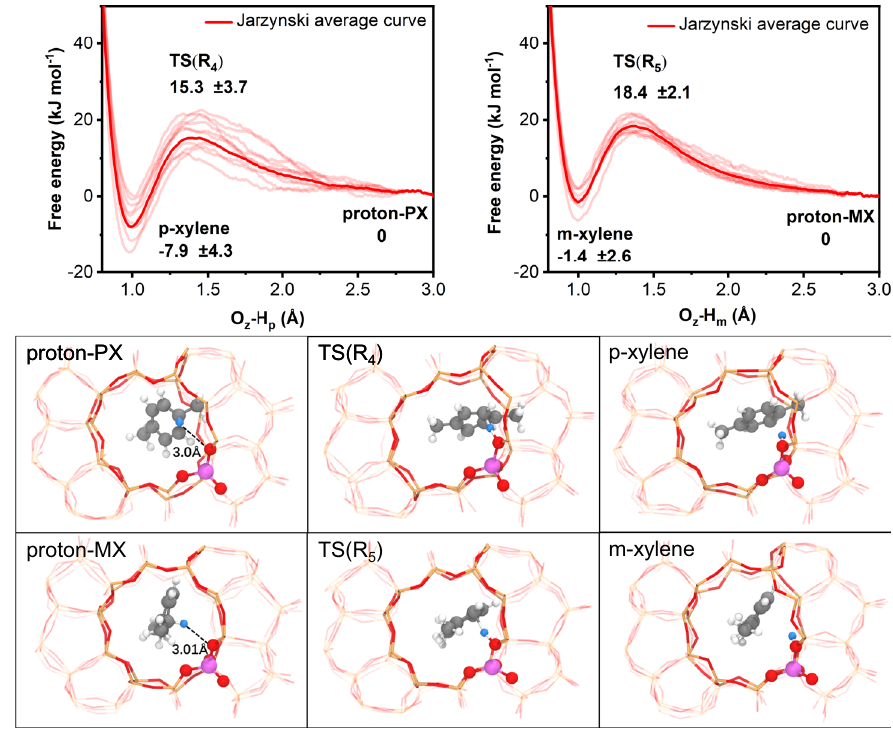
Fig. 5 Free energy pro fi les of proton – PX and proton – MX deprotonation. These pro fi les were obtained from slow-growth simulations. Thin lines are the work curves of individual simulations and the thick line is the free energy pro fi le obtained from Jarzynski equality. The values of free energy and the standard deviation of works are also shown in the fi gure. The corresponding structures of the reactants, transition states and products for p-xylene and m- xylene are presented in the lower panel. The blue ball represents the reacting H atom.